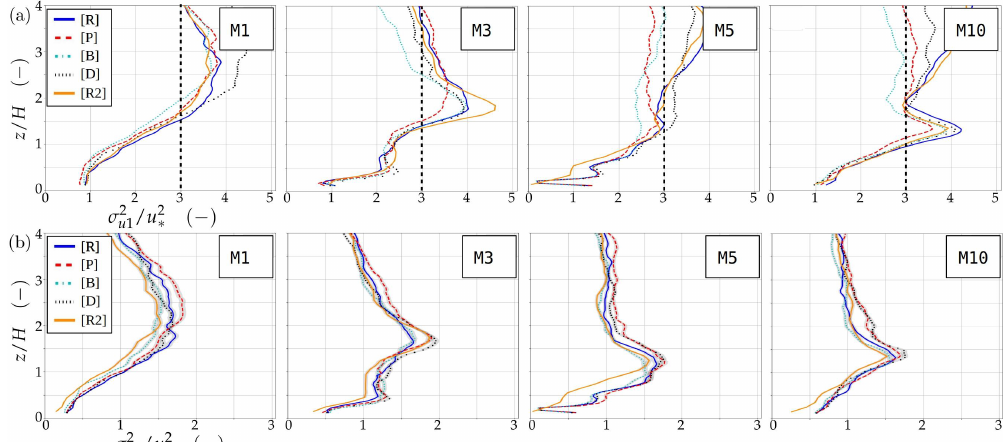
Figure 15. A juxtaposition of original ( a ) and filtered ( b ) dimensionless streamwise-aligned velocity variance profiles at selected measurement locations: The range on ( b ) axes has been modified to allow better differentiation of the differences. Black dashed lines have been added to ( a ) to indicate the variance range of ( b )